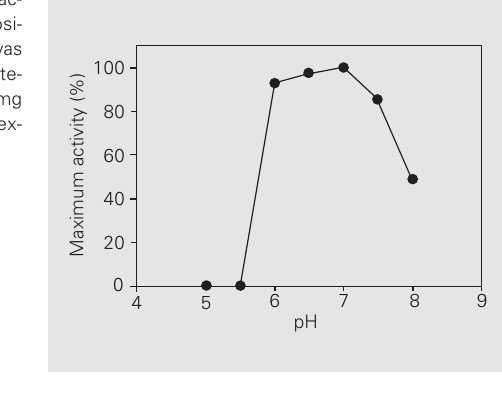
Figure 5. (cid:0) Inactivation of (cid:1) -L- fucosidase with time. Epimasti- gote extracts were preincubated at 28 (cid:1) C (squares) or 37 (cid:1) C (circles) for the periods of time shown on the abscissa. Activity was meas- ured by the standard enzymatic